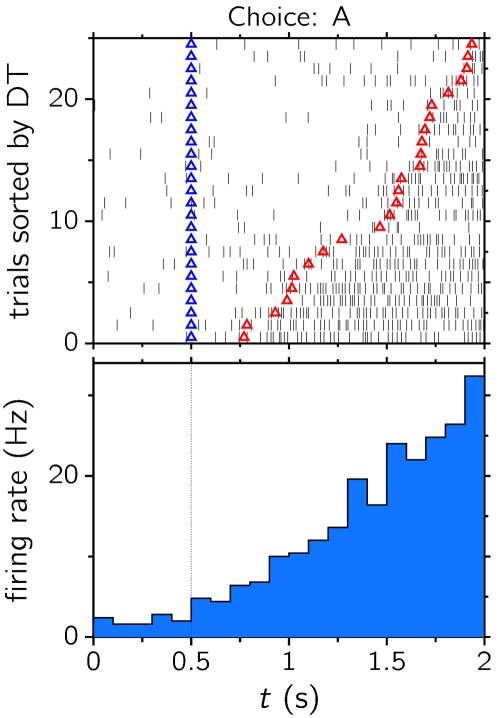
Upper row: rasters of a single cell in population A, across 20 different trials and sorted by decision time.Bottom row: trial-averaged firing rate. In all these 20 trials the network chose option A (in physiological terms, the target choice is in the response field (RF) of the recorded cell). Blue triangles: stimulus onset. Red triangles: decision time, determined following the criterion shown in Figure 4. λ̅ = 5 Hz, w
+ = 1.75, N = 500.